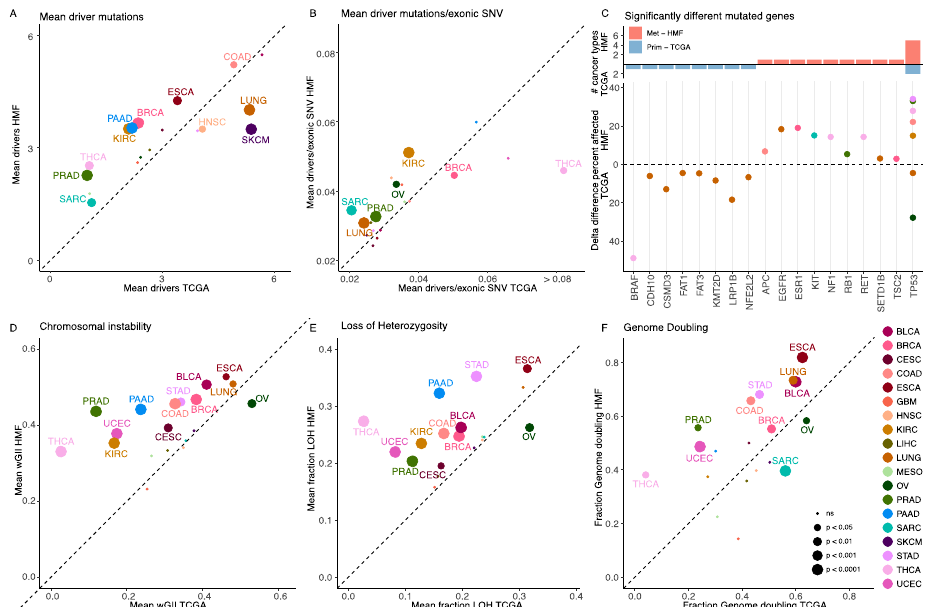
Figure 2. Quantitative analysis of mutations and copy number alterations. ( A ) Scatterplot of the mean number of driver mutations per cancer type in primary vs. metastatic cancer. The size of the bubbles represents the significance of the difference in mean between primary and metastatic samples. ( B ) Scatterplot of the mean number of driver mutations per 100 exonic SNV per cancer type in primary vs. metastatic cancer. The size of the bubbles represents the significance of the difference in mean between primary and metastatic samples. ( C ) The result of the mutation enrichment analysis on gene level is shown in the top panel, with the number of cancertypes the gene is found enriched in. Below the fraction of delta difference in mutations for each of the enriched genes, for each significant cancer type. ( D ) Scatterplot of the mean value of chromosomal instability determined by the wGII score, per cancer type in primary vs. metastatic cancer. The size of the bubbles represents the significance of the difference in mean between primary and metastatic samples. ( E ) Scatterplot of the mean fraction of loss of heterozygosity per cancer type in primary vs. metastatic cancer. The size of the bubbles represents the significance of the difference in mean between primary and metastatic samples. ( F ) Scatterplot of the fraction of patients with genome doubling per cancer type in primary vs. metastatic cancer. The size of the bubbles represents the significance of the difference between the percentage of samples with genome doubling between primary and metastatic, calculated by Fisher’s exact test. For all panels, colours indicate cancer type, as shown in bottom right legend.